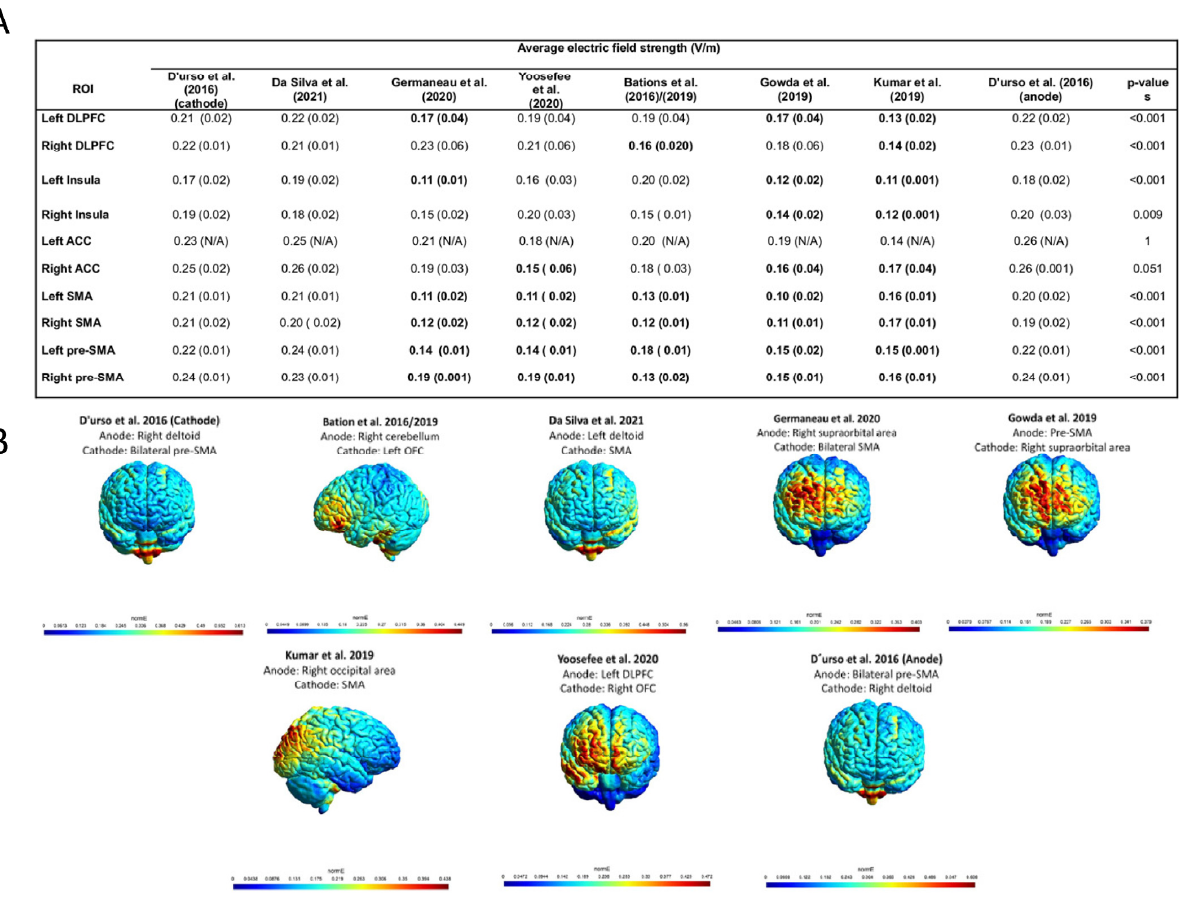
Figure 3. Electric field modeling analysis [19–26]. ( A ) Mean and standard deviation of electric field strength of montages across different brain regions of interest. ( B ) Electric field distribution based